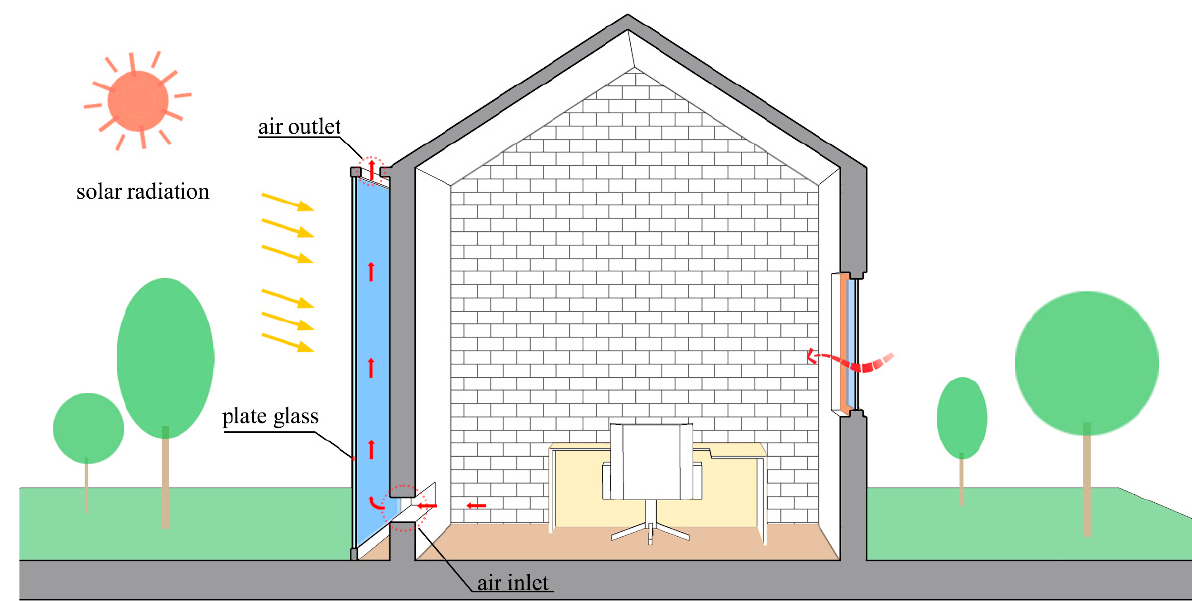
Figure 1. Diagram of the wall-mounted solar chimney.